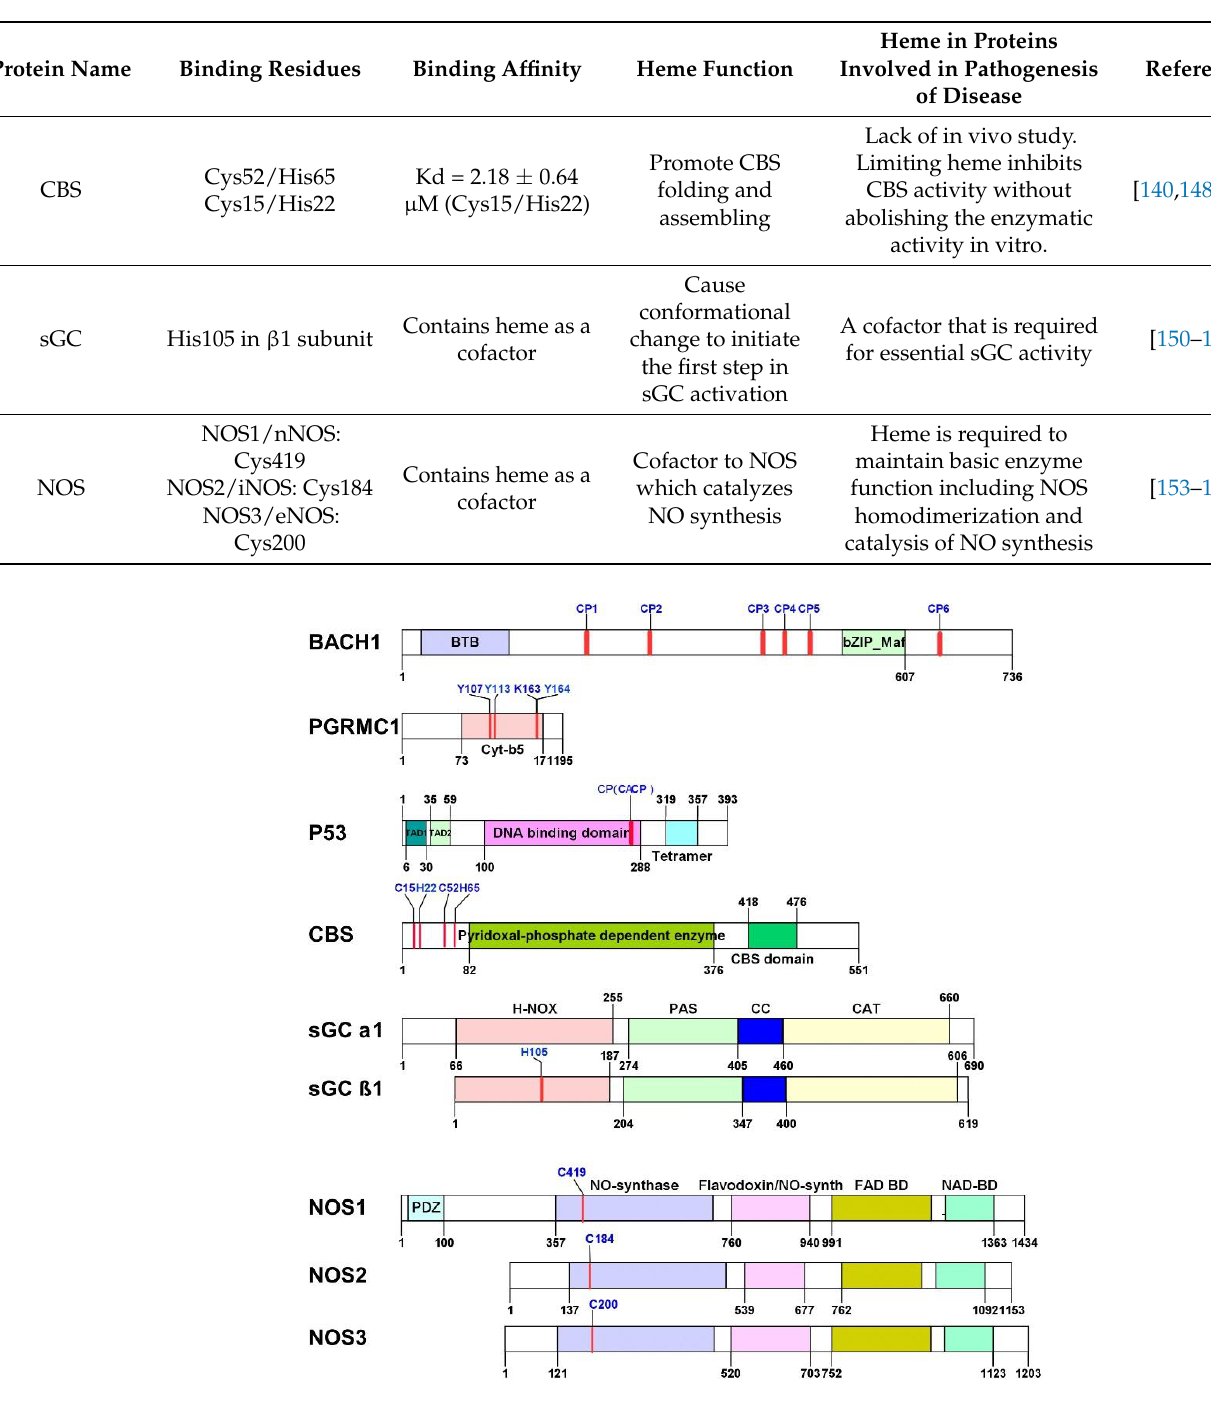
Table 1. Heme regulated multifunctional signal transducers and regulators involved in disease diagnoses and treatments. Protein